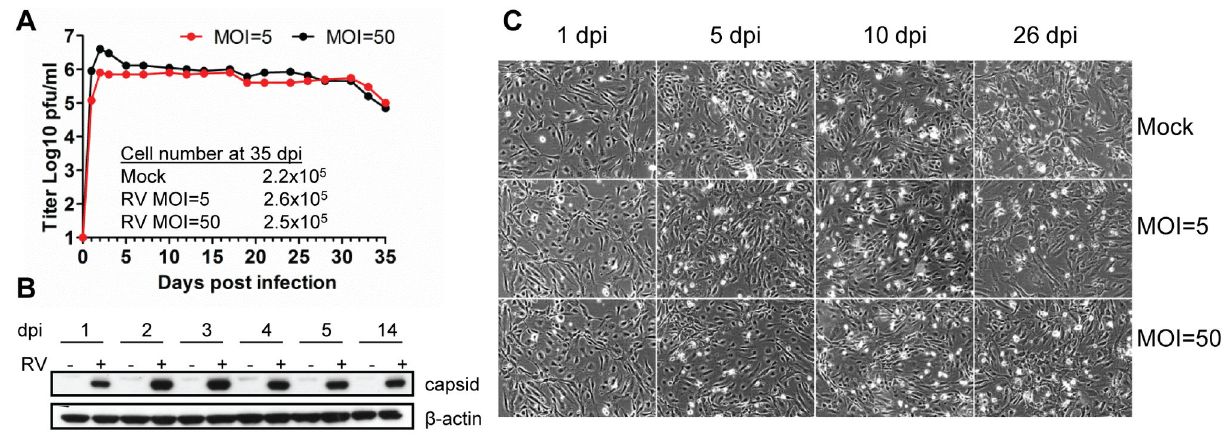
Figure 5. RV persistence in HUVEC. ( A ) Growth curves of RV-Dz at different MOI. Media were collected every 2-3 days and the extracellular viruses were titered on Vero cells in duplicate. The adherent cells on the flasks at 35 dpi were collected by trypsinization into 4 ml of media and counted (cells/ml) using a Scepter cell counter. The representative results of two independent experiments are shown. ( B ) Western blot analysis of RV capsid protein expression in persistently infected HUVEC. The blot was re- probed with β-actin MAb to confirm equal protein loading. ( C ) Phase contrast images of cells at different times postinfection showing the lack of CPE in HUVEC persistently infected with RV-Dz